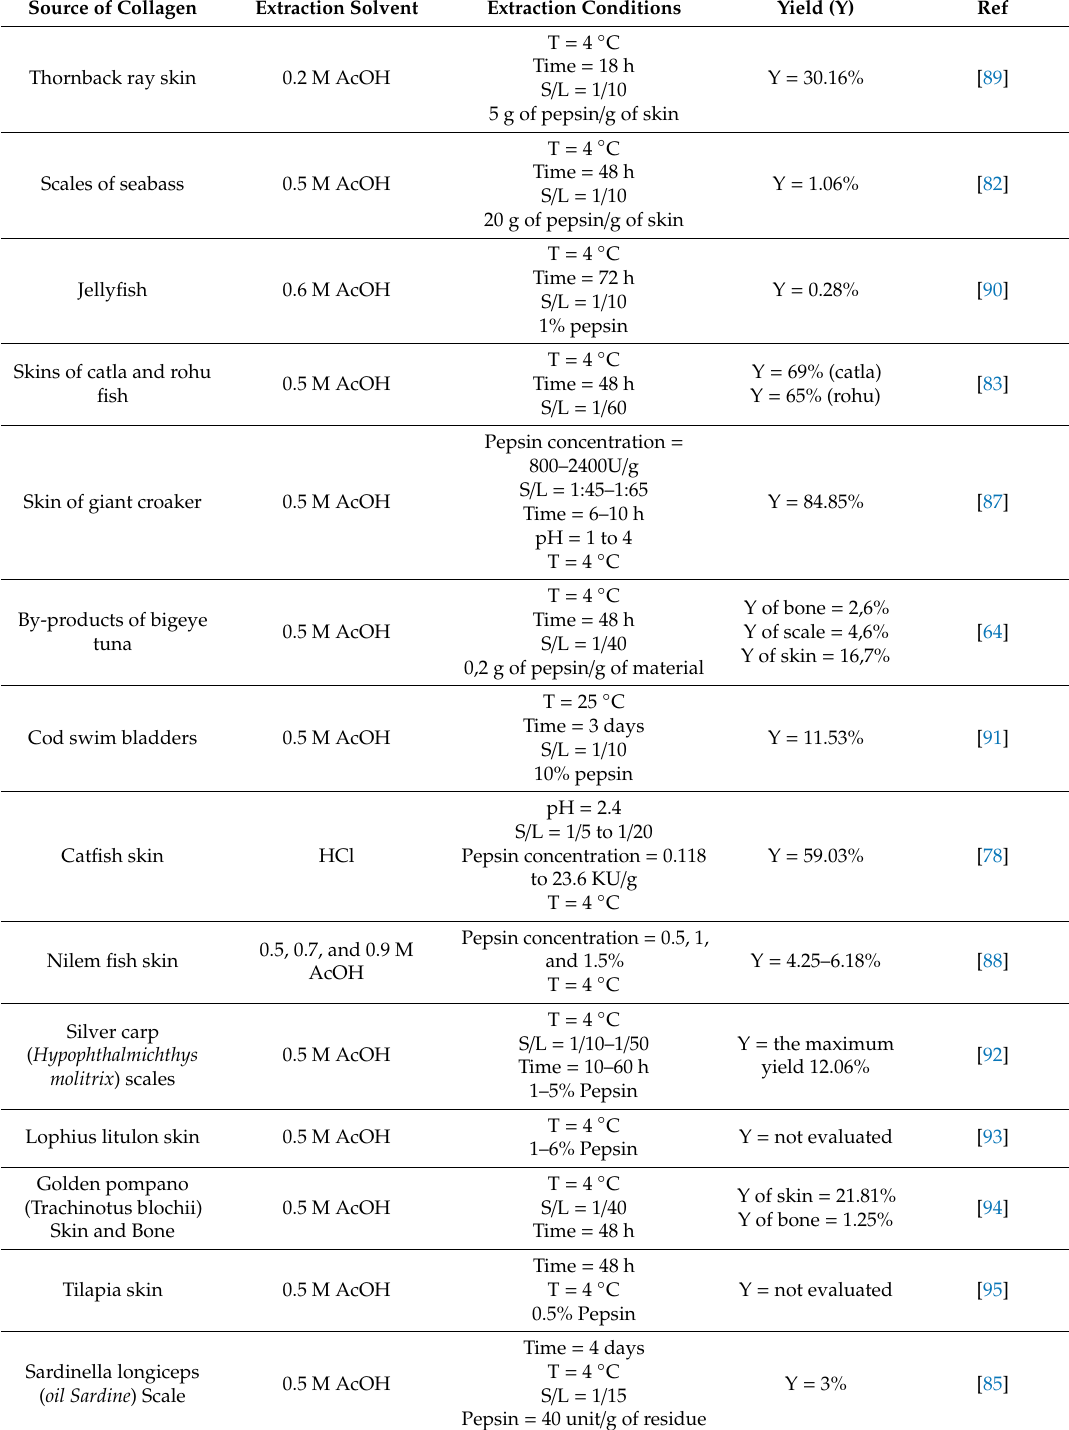
Table 3. Summary of the experimental conditions employed for fish collagen isolation using pepsin aided AcOH